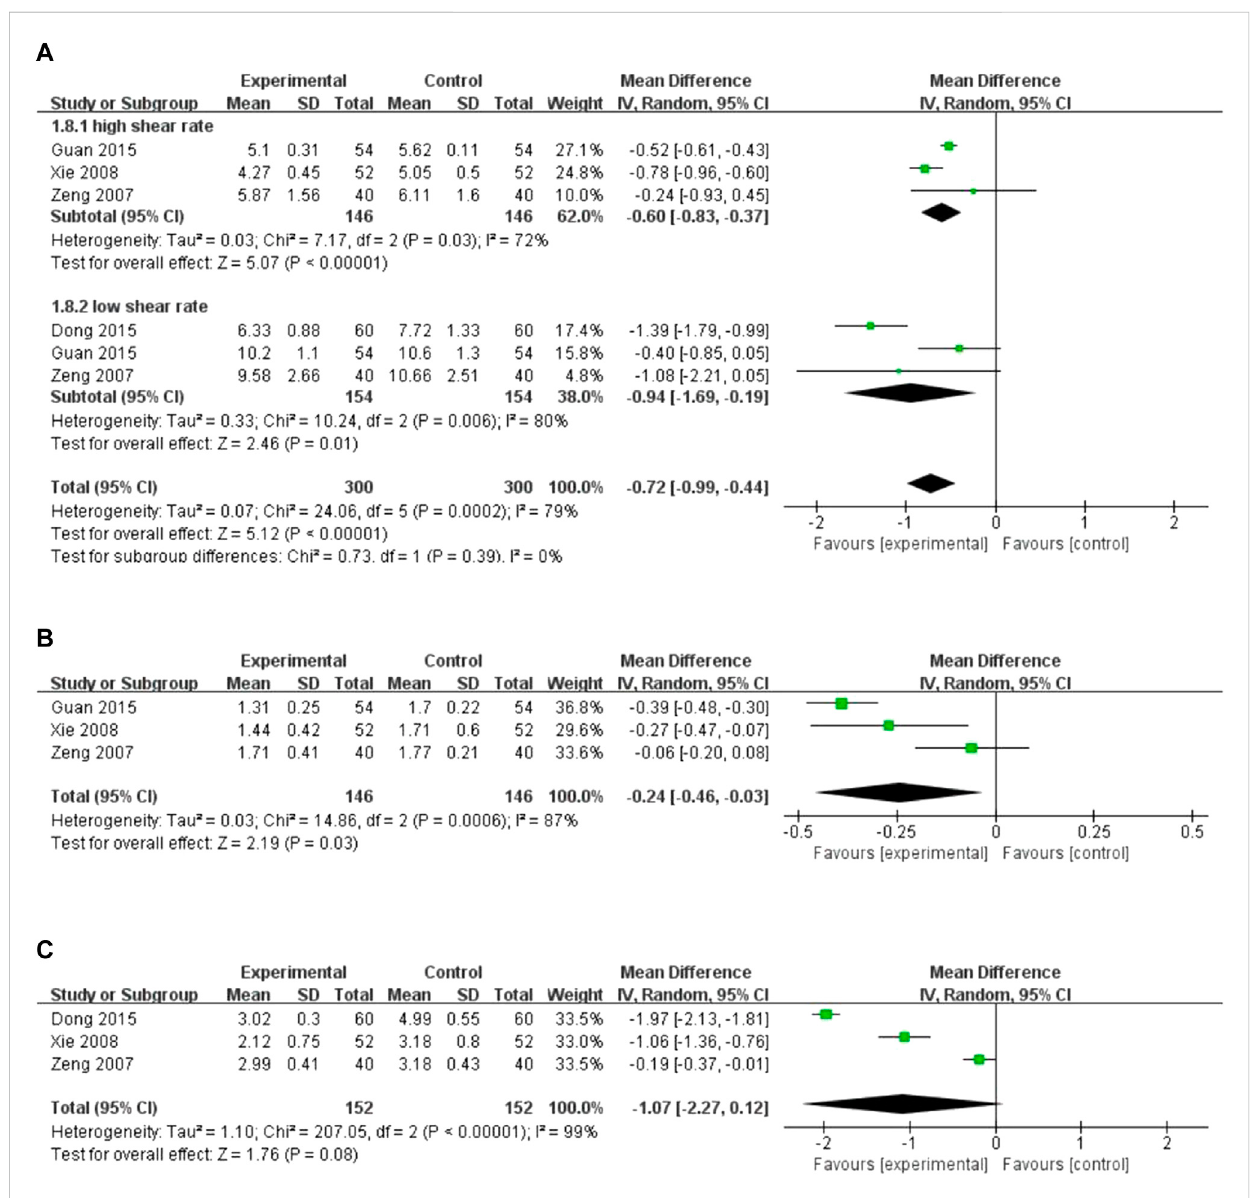
FIGURE 8 Forest plot of blood lipids level. (A) Whole blood viscosity. (B) Plasma viscosity. (C) Fibrinogen levels.